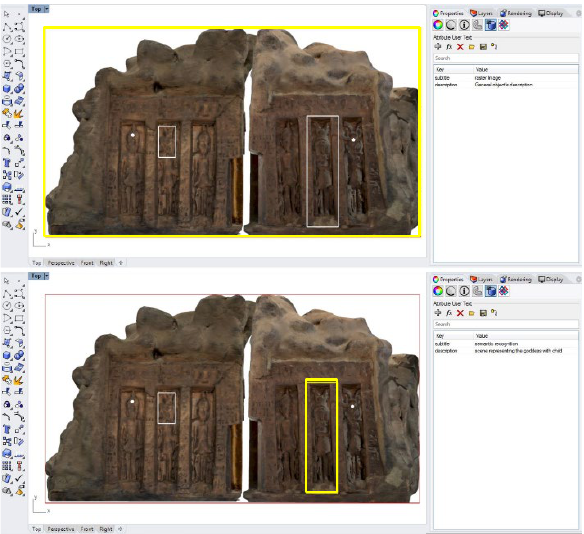
Figure 10. Annotation of geometry is done by following a